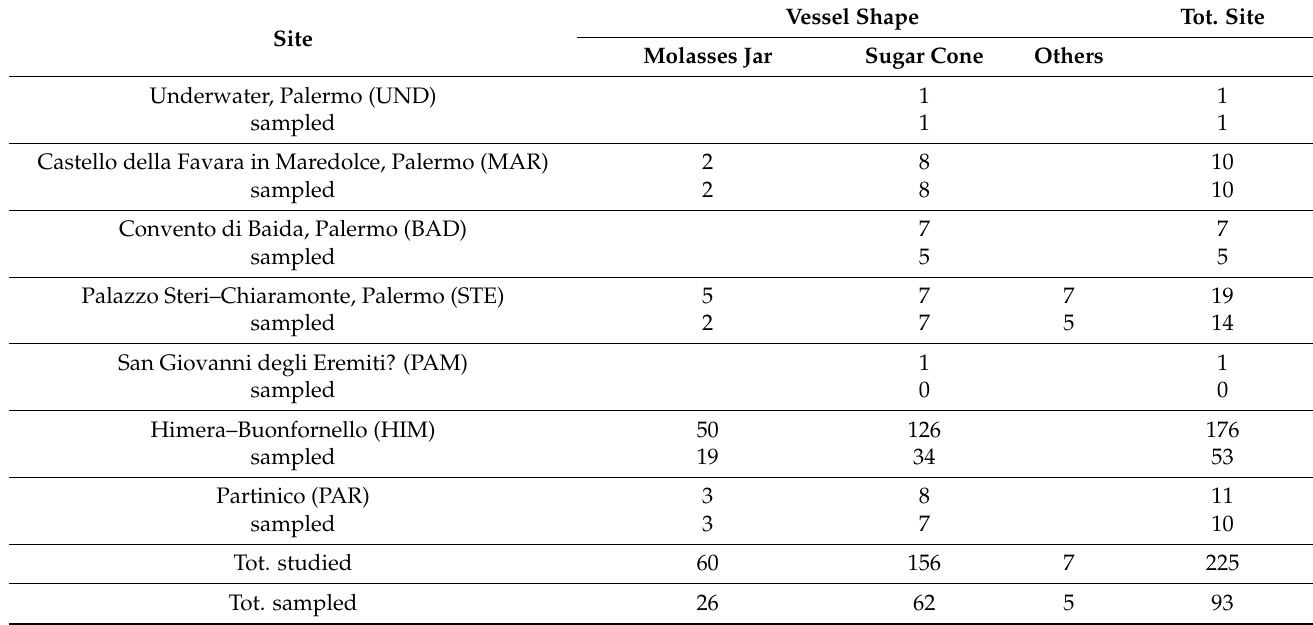
Table 1. Archaeological sites studied and sampled for this study. Site